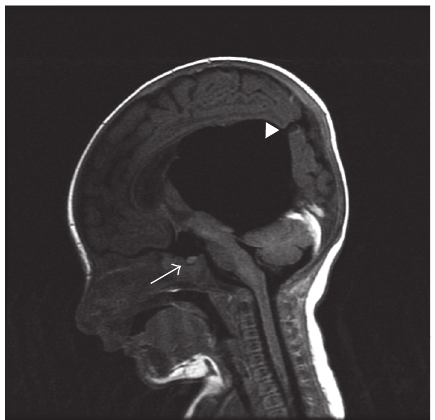
Figure 1: The white arrow indicates the hypoplastic anterior pituitary. Note that the posterior pituitary bright spot is not seen. The solid white triangle shows the arachnoid cyst status after fenestration.